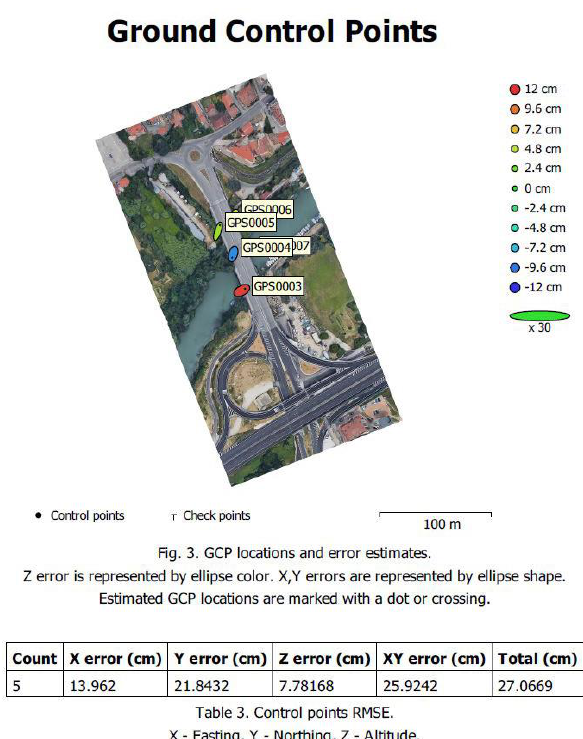
Figure 16: ground verification points. GCP location and error estimates in Google